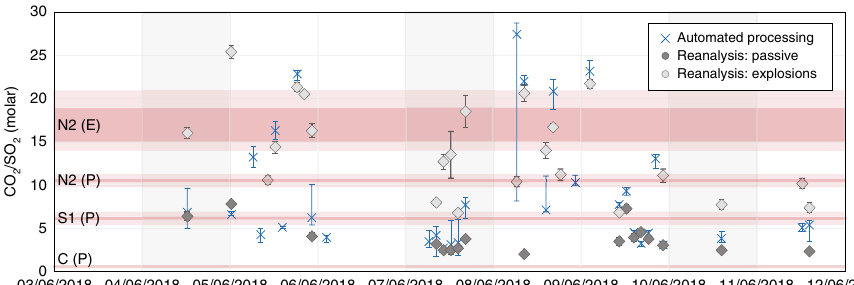
Fig. 8 A comparison of ground based on UAS CO 2 /SO 2 molar ratios. Ground-based multi-GAS measurements from the permanent monitoring station located on the crater rim of Stromboli. Timeseries of CO 2 /SO 2 molar gas ratios measured 4 – 11 June 2018, showing automatically processed (blue crosses) and reanalysed (grey symbols) ratios. Passive degassing (dark grey symbols) represents persistent activity measured over tens of minutes, while explosive degassing (light grey symbols) represents transient peaks lasting <60 s. Red shaded bars correspond the aerial vent-speci fi c gas compositions and 95% con fi dence intervals presented in Table 1 for passive (P) and explosive